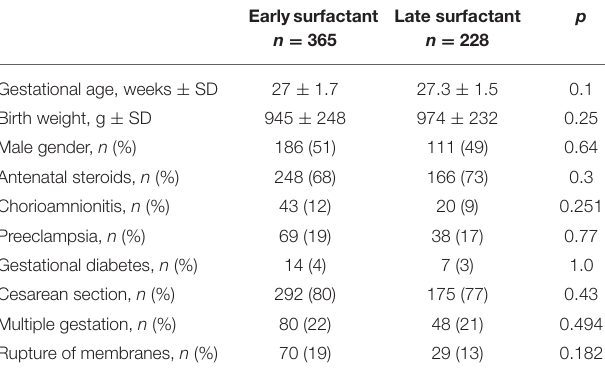
TABLE 1 | Basic clinical characteristics of study groups.